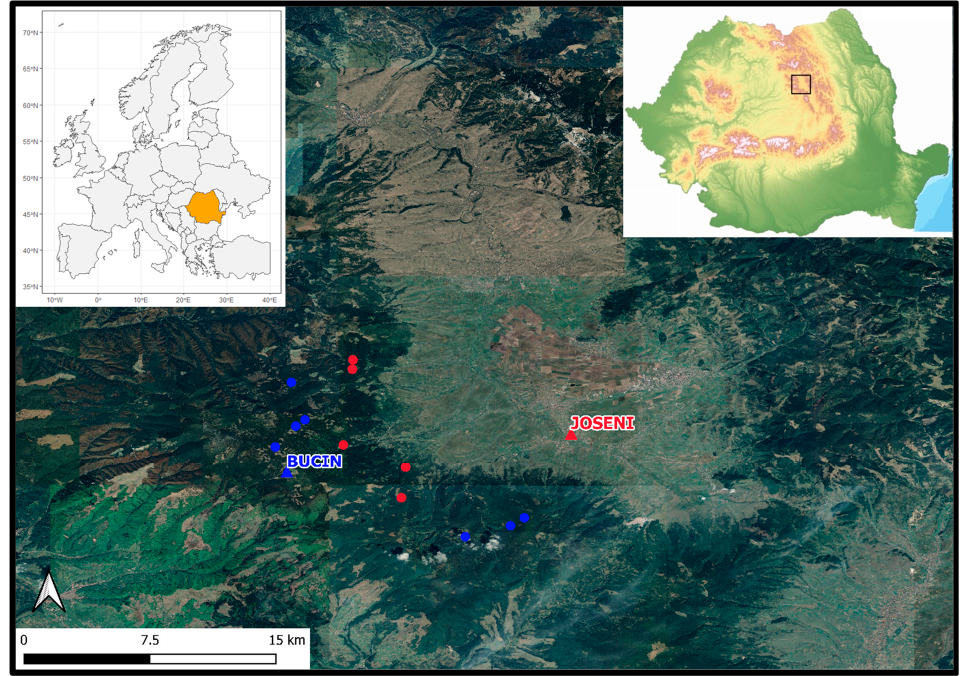
Figure 6. The study localization—with blue the high elevation sites, up-hill weather station, and with red the low elevation sites, valley weather station (image source: https://geoportal.ancpi.ro (ac- cessed on 1 August 2022).; https://earth.google.com (accessed on 1 August